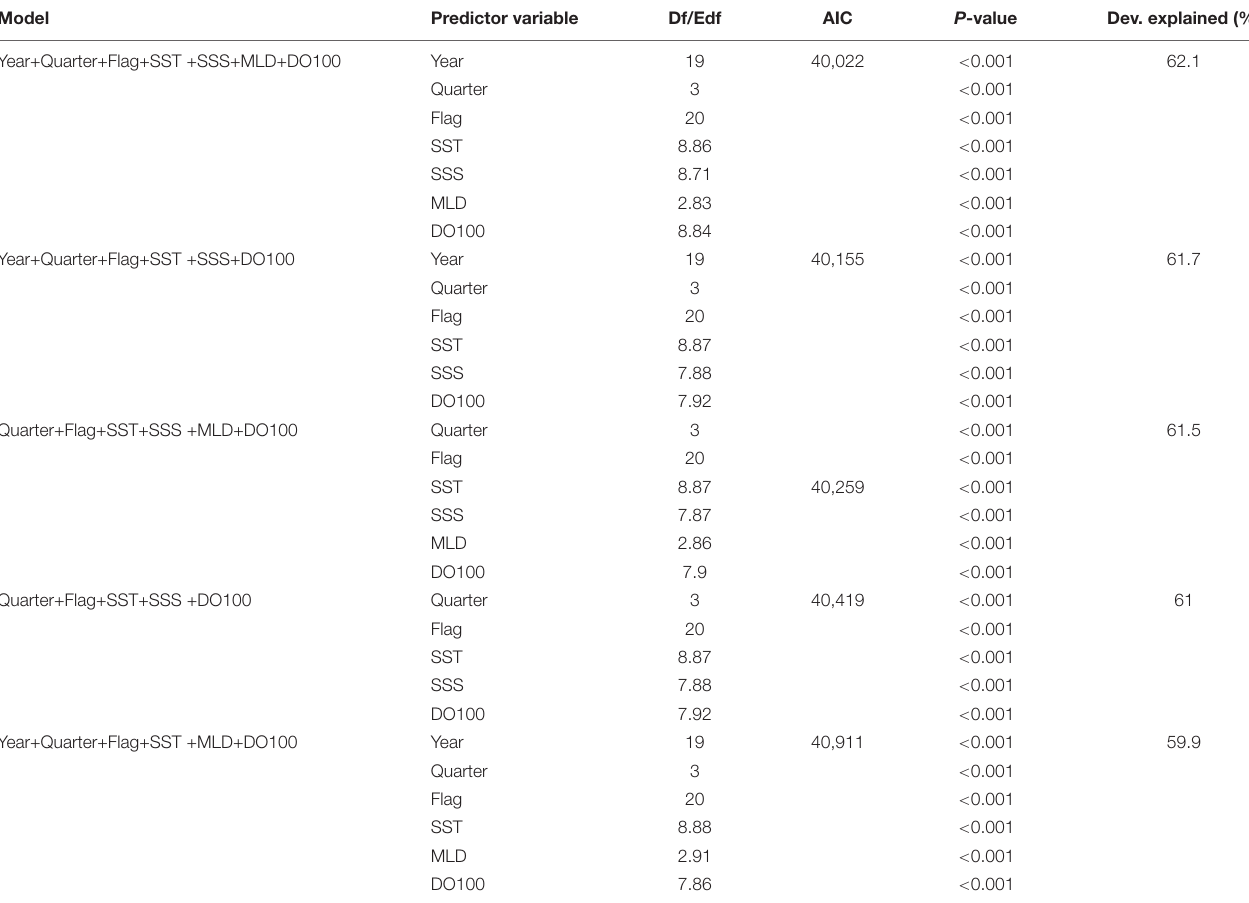
TABLE 2 | Top five candidate models selected by the dredge function of the “MuMIn” R-package. Model Predictor